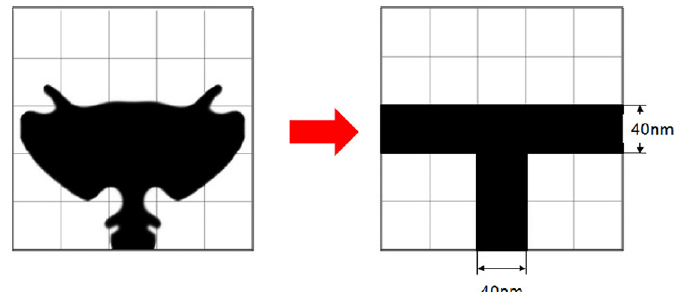
Figure 2. Simplified nanostructure with T-profile derived from the nanoparticle shape. Reprinted with permission from [27]. Copyright © 2014 AIP Publishing